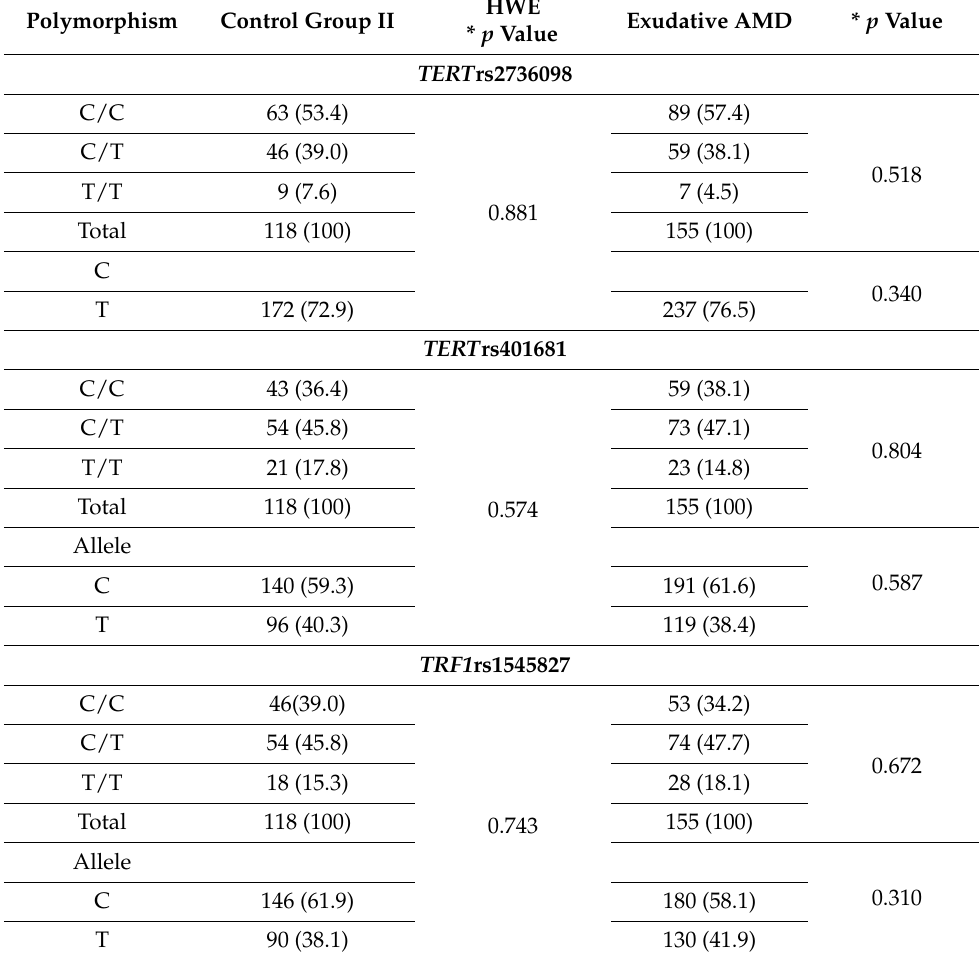
Table 3. Frequencies of genotypes and alleles of TERT rs2736098, rs401681, TRF1